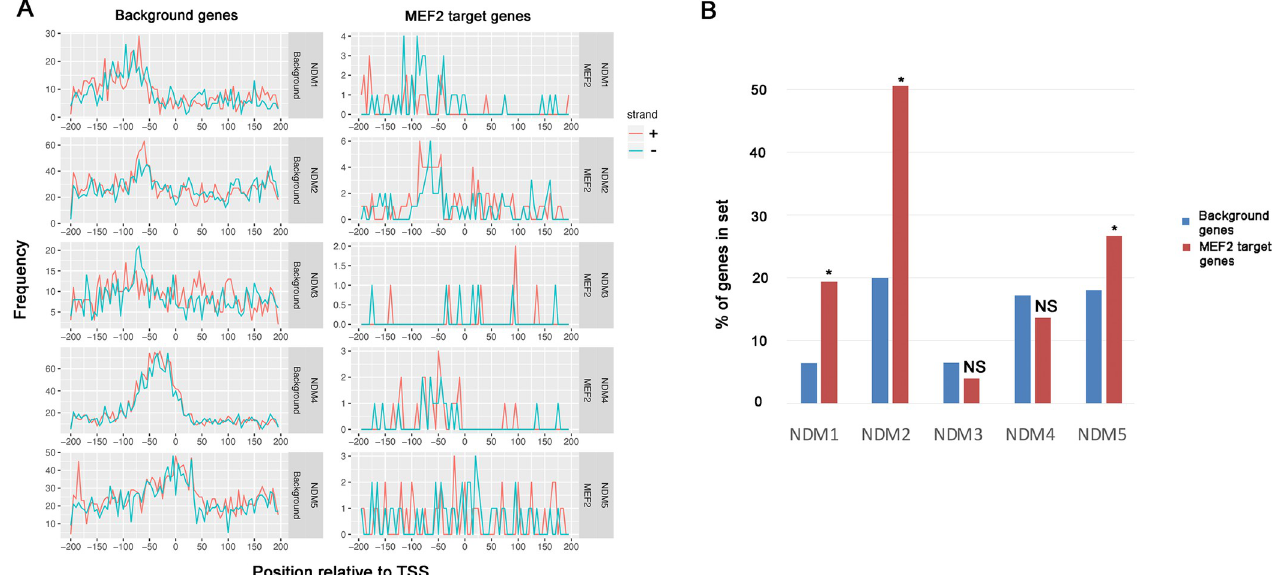
Fig 3. Occurrence of non-directional promoter motifs (NDMs) in control and MEF2 target genes. A: Frequency graphs showing the occurrence of each indicated motif in promoters from -200 to +200 relative to the transcription start site. Frequency data, representing the number of times that the element is detected at the indicated location, are shown separately for occurrences on the coding strand (+, red) versus the non-coding strand (-, blue). Graphs representing data from background genes are on the left of each pair of graphs, and MEF2 target genes are on the right of each pair. B: Relative frequencies of promoter elements in background and MEF2 datasets. NS, not significantly enriched in the MEF2 dataset; � , significantly P < 0.01) enriched in the MEF2 dataset.